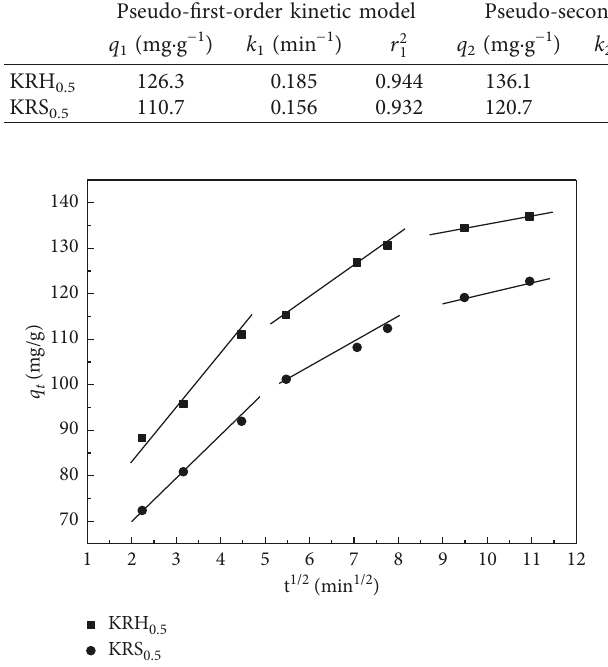
Figure 8: Intraparticle diffusion plots for the MG adsorption onto KRH 0.5 and KRS 0.5 .